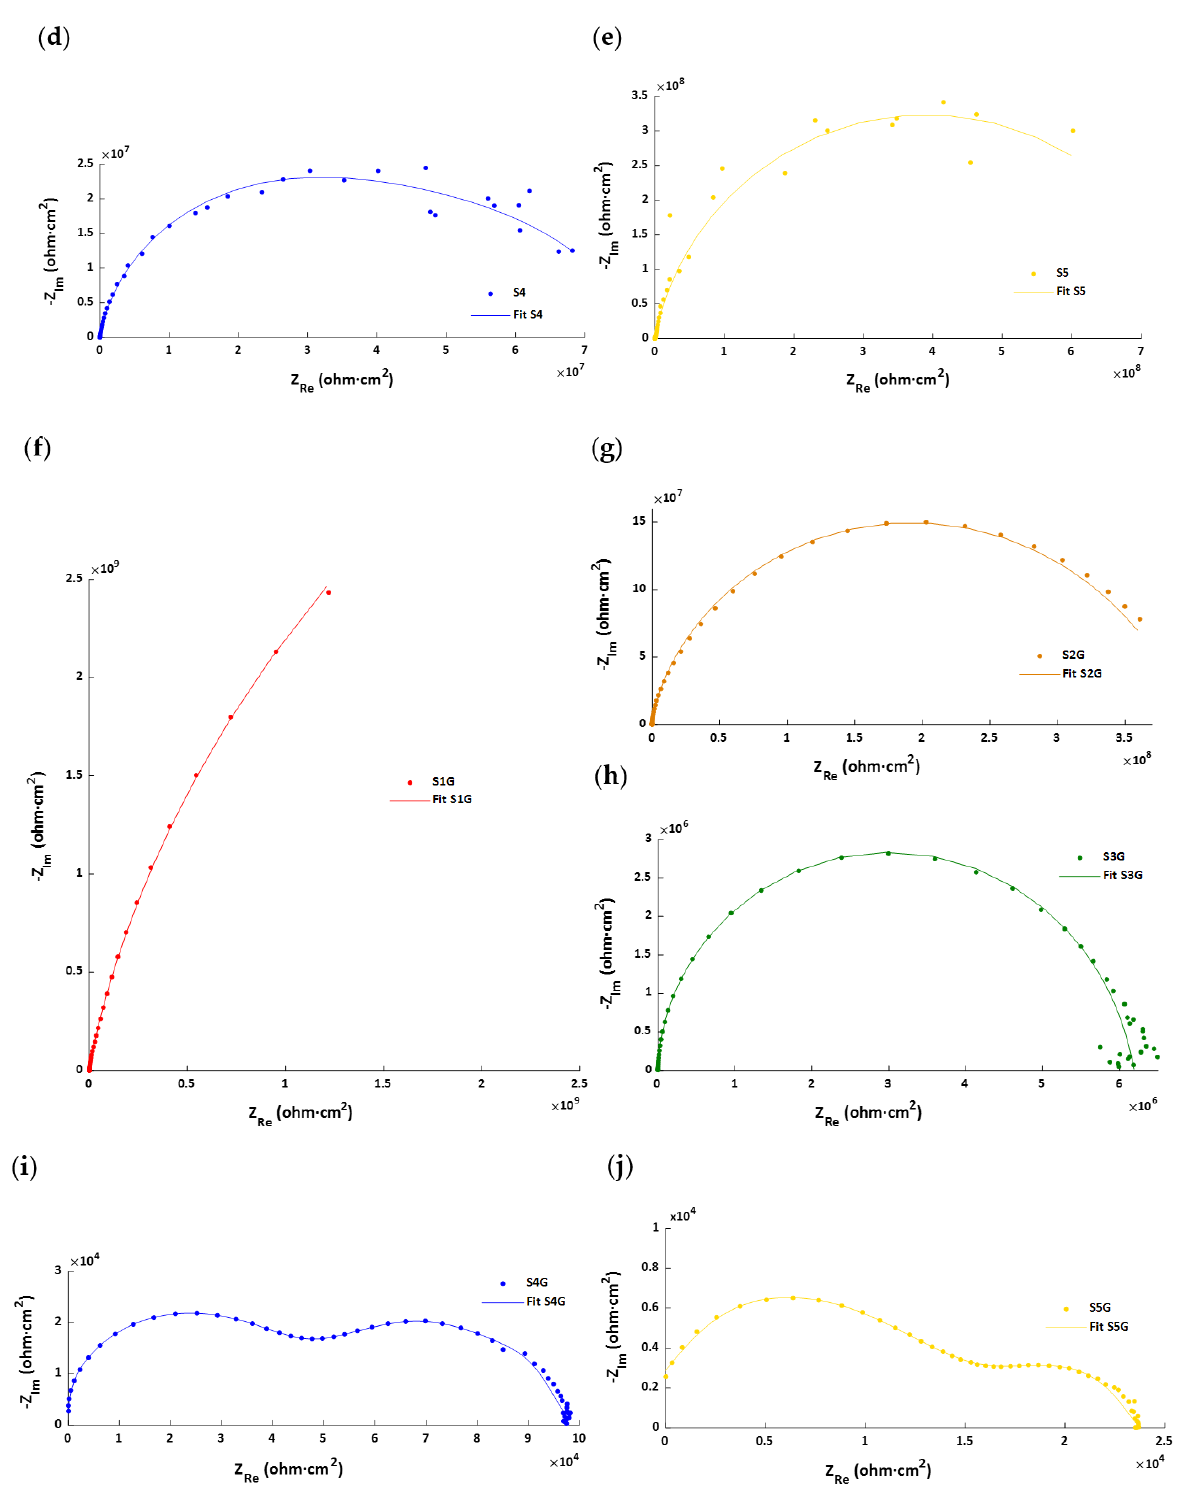
Figure 17. Nyquist plots corresponding to the samples ( a ) S1, ( b ) S2, ( c ) S3, ( d ) S4, ( e ) S5, ( f ) S1G, ( g ) S2G, ( h ) S3G, ( i ) S4G, and ( j ) S5G.